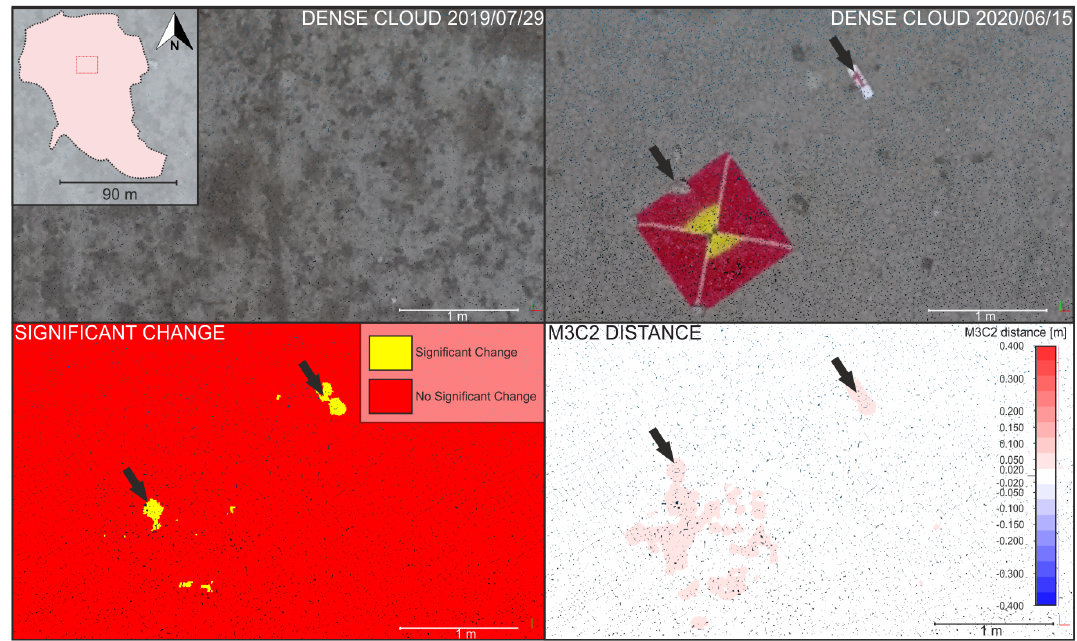
Figure 11. In the upper part of the figure, the dense point clouds of the two surveys of the same area carried out on 29 July 2019 (left) and 15 June 2020 (right) are shown. In the lower part are the clouds with the significant change (left) and the M3C2 distance (right). The arrows indicate the significant changes between the surveys. The calculated changes between the two clouds estimate an altitude increase of about 6.3cm for the fragment of rock used to maintain the target in position and an increase in height of about 2.5cm for the calliper which is 2cm thick. The reference system is WGS 84/UTM zone 33N.